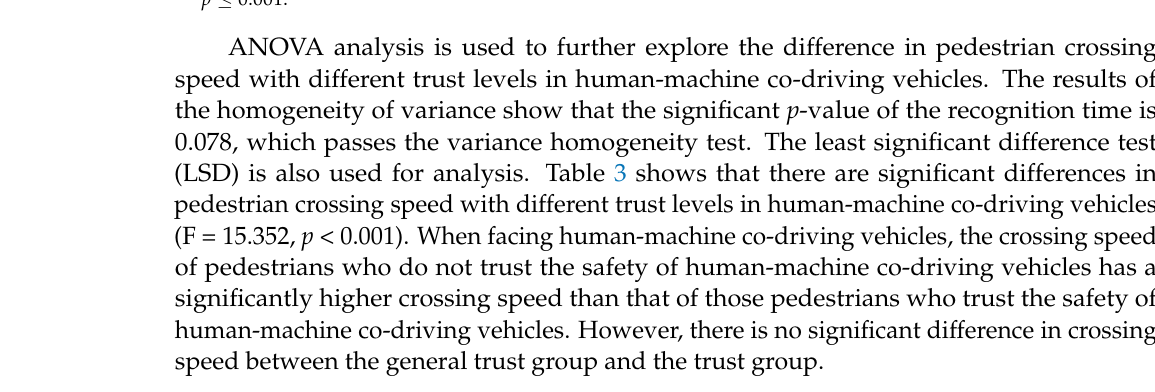
Table 3. LSD multiple comparisons of trust in human-machine co-driving